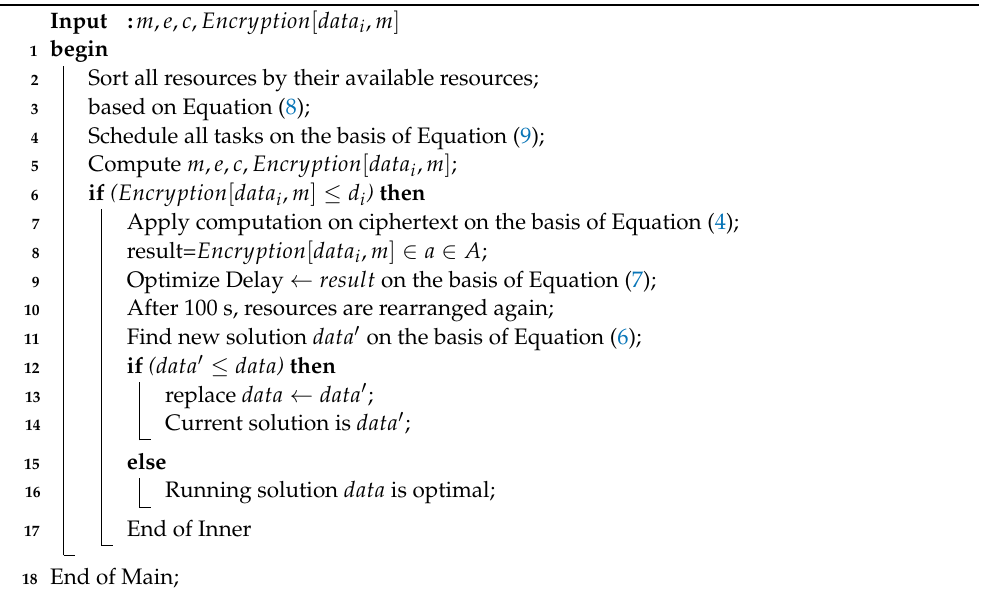
Algorithm 4: Adaptive task-scheduling and variable neighbor-searching